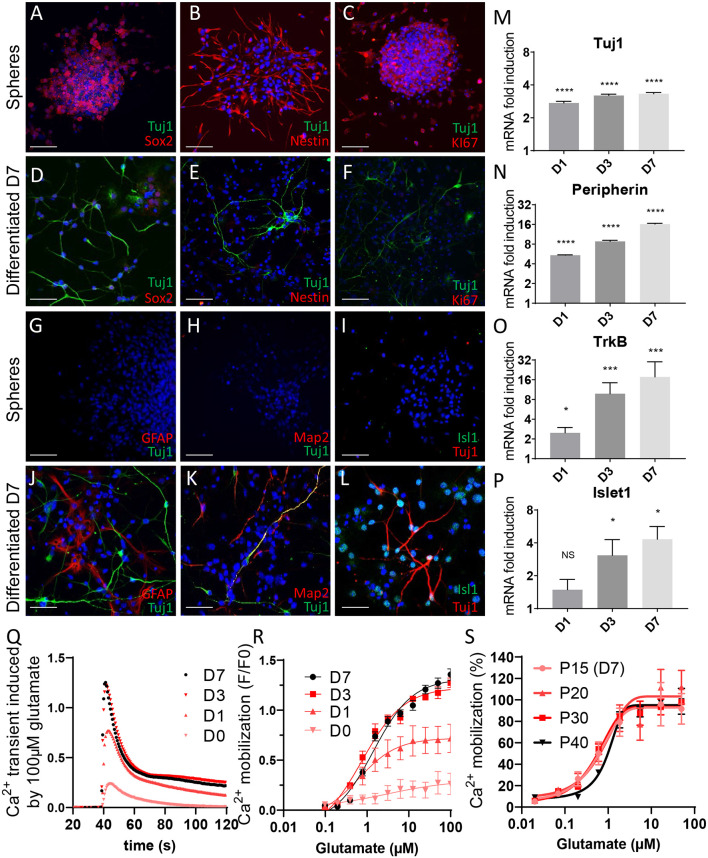
Phenotypical characterization of phoenix auditory neurons. (A–F) Three days following passaging, neurospheres were plated on Matrigel-coated coverslips. (A–C) Four hours following the plating, neuroprogenitor spheres were fixed, permeabilized, and stained for the indicated markers. (D–F) Seven days’ differentiated auditory neurons were used as control. (A,D) BIII-tubulin and Sox2 in neuroprogenitors and differentiated cells. (B,E) BIII-tubulin and nestin in neuroprogenitors and differentiated cells. (C,F) BIII-tubulin and KI67 in neuroprogenitor spheres and differentiated auditory neurons. Scale bar: 50 μm. Isolated phoenix auditory neuroprogenitors were differentiated on Matrigel-coated (G–L) coverslips for immunofluorescence experiments, (M–P) six-well plates for qPCR experiments, or (Q–R) 96-well plates for Ca2+ transients measurement for the indicated time points (1–7 days). (G–L) Seven days’ differentiated auditory neurons were fixed, permeabilized, and stained for the indicated markers. (G–I) Undifferentiated spheres of progenitors were used as control. (G,J) BIII-tubulin and astrocyte marker GFAP, (H,K) BIII-tubulin and mature neurons marker Map2, (I,L) BIII-tubulin and sensory neurons marker Isl1, (M–P) mRNA level of several auditory neuron markers such as (M) BIII-tubulin, (N) peripherin, (O) TrkB, and (P) Islet1 was assessed by qPCR during the differentiation process (after 1, 3, or 7 days of differentiation). Scale bar: 50 μm. (Q,R) Phoenix auditory neurons were differentiated for the indicated times, loaded with Ca2+-sensitive ratiometric probe (FLUO-8), and stimulated with increasing concentrations of glutamate (0.02–100 μM). Traces represent (Q) maximum amplitudes (F/F0) in response to 100 μM glutamate and (R) dose–response curves, as recorded along the differentiation process at different time points (after 1, 3, or 7 days of differentiation). (S) Glutamate dose–response induced Ca2+ mobilization in D7 differentiated phoenix auditory neurons as recorded at different passages (from P15 to P40). Data represent the average ± SEM of three independent experiments. *p < 0.05, ***p < 0.005, ****p < 0.0005, NS: non significant.